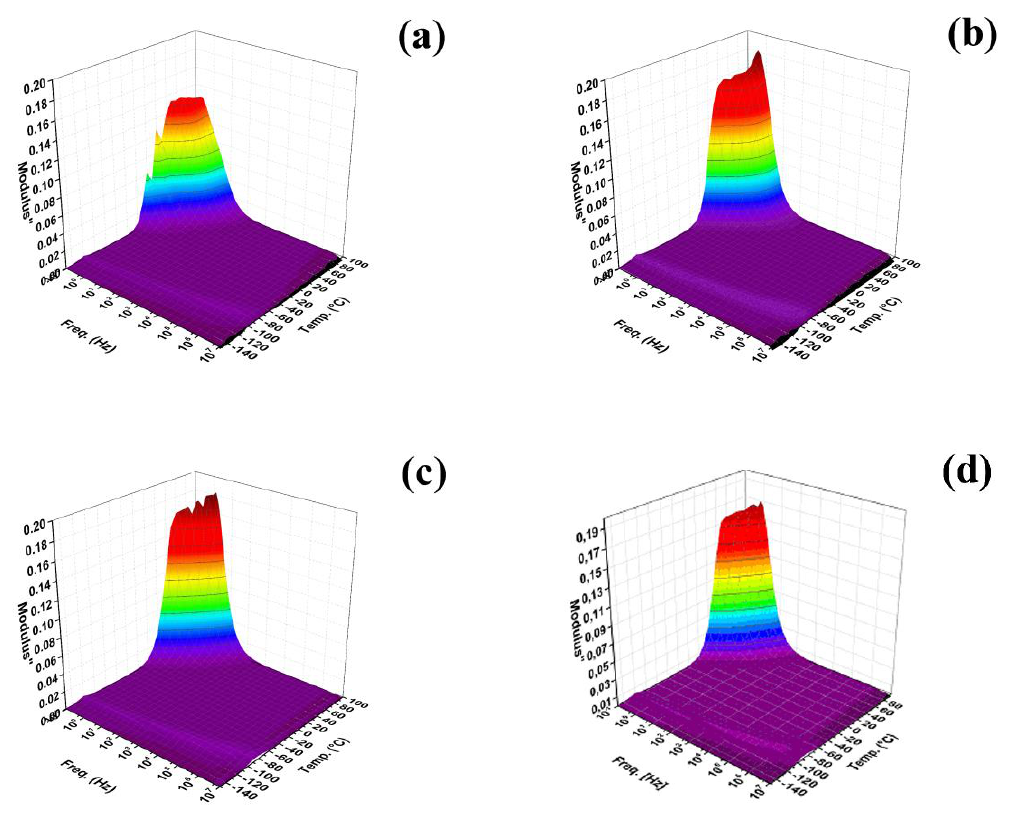
Figure 7. 3D plots of the dielectric properties of the neat PDMS matrix, ( a ) neat GO-PDMS; ( b ) GO- GO-PGMA 1; ( c ) and GO-PGMA 2; ( d ) All at 0.1 vol. % content in PGMA 1; ( c ) and GO-PGMA 2; ( d ) All at 0.1 vol. % content in PDMS.